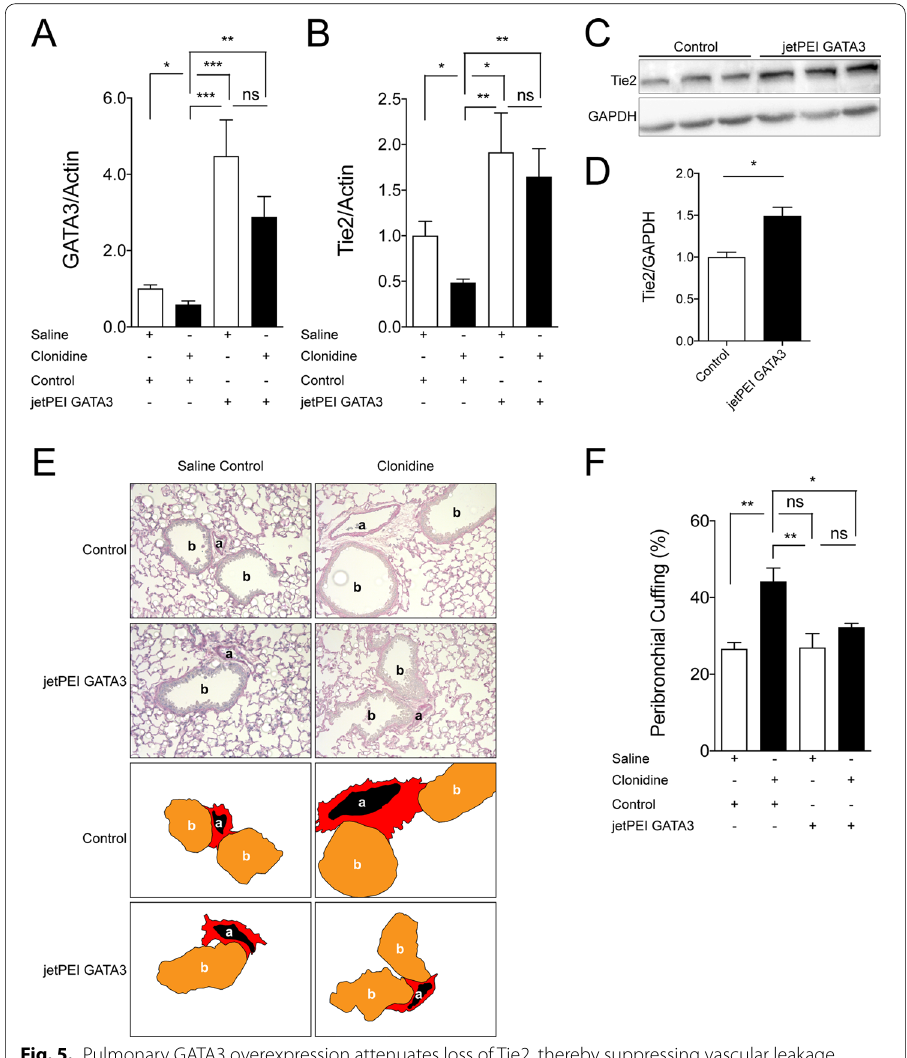
Fig. 5. Pulmonary GATA3 overexpression attenuates loss of Tie2, thereby suppressing vascular leakage in vivo. A GATA3 mRNA and ( B ) Tie2 mRNA expression in the lungs of GATA3 overexpressing (jetPEI GATA3) and control mice with (clonidine) and without (saline) the induction of hypotension (* p < 0.05, ** p < 0.01, *** p < 0.001, ns not significant, n 6 per group). C Representative immunoblot of whole-lung lysates = = for Tie2 protein expression in GATA3 overexpressing (jetPEI GATA3) and control mice. D Densitometric quantification of blots (* p < 0.05, n 4 per group). E Periodic acid-Schiff (PAS) staining of paraffin-embedded = lung tissue in GATA3 overexpressed and control mice. All images show bronchus (b), their corresponding arteriola (a) and the peribronchial cuffing (a surrogate of lung edema) The schematic illustration below highlights this peribronchial cuff area (in red). F Semi-quantification of peribronchial cuffing was performed by surveying whole lung sections. (* p < 0.05, ** p < 0.01, ns not significant. n 4 per = =